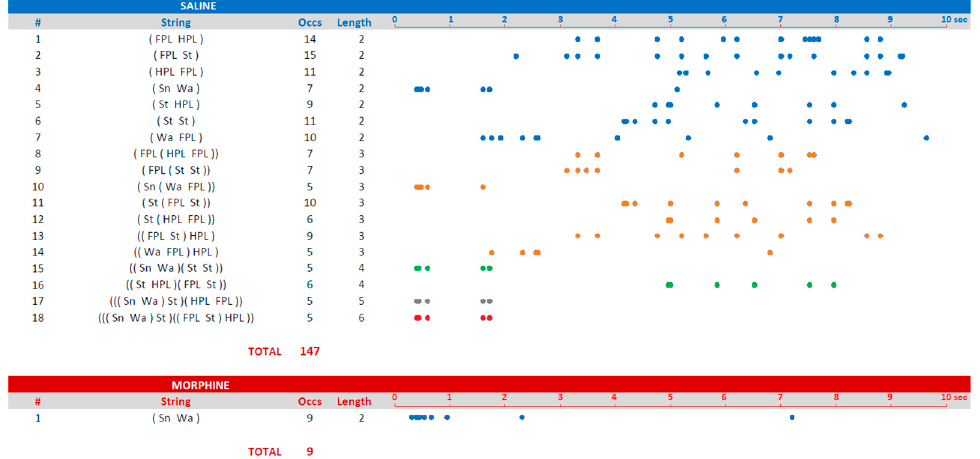
Figure 5. Results of T-pattern detection expressed as terminal strings (events in brackets) and the corresponding raster-plot. Dots indicate the onset of the first event of each T-pattern (see Figure 4). Numbers on the left of each row indicate the corresponding T-pattern presented in Figure 4. For illustrative purposes, pattern length is presented using the same colors as in Figure 4. X-axis = time in seconds. Data obtained from the analysis of two groups each encompassing 10 subjects. For abbreviations, see Figure 1.